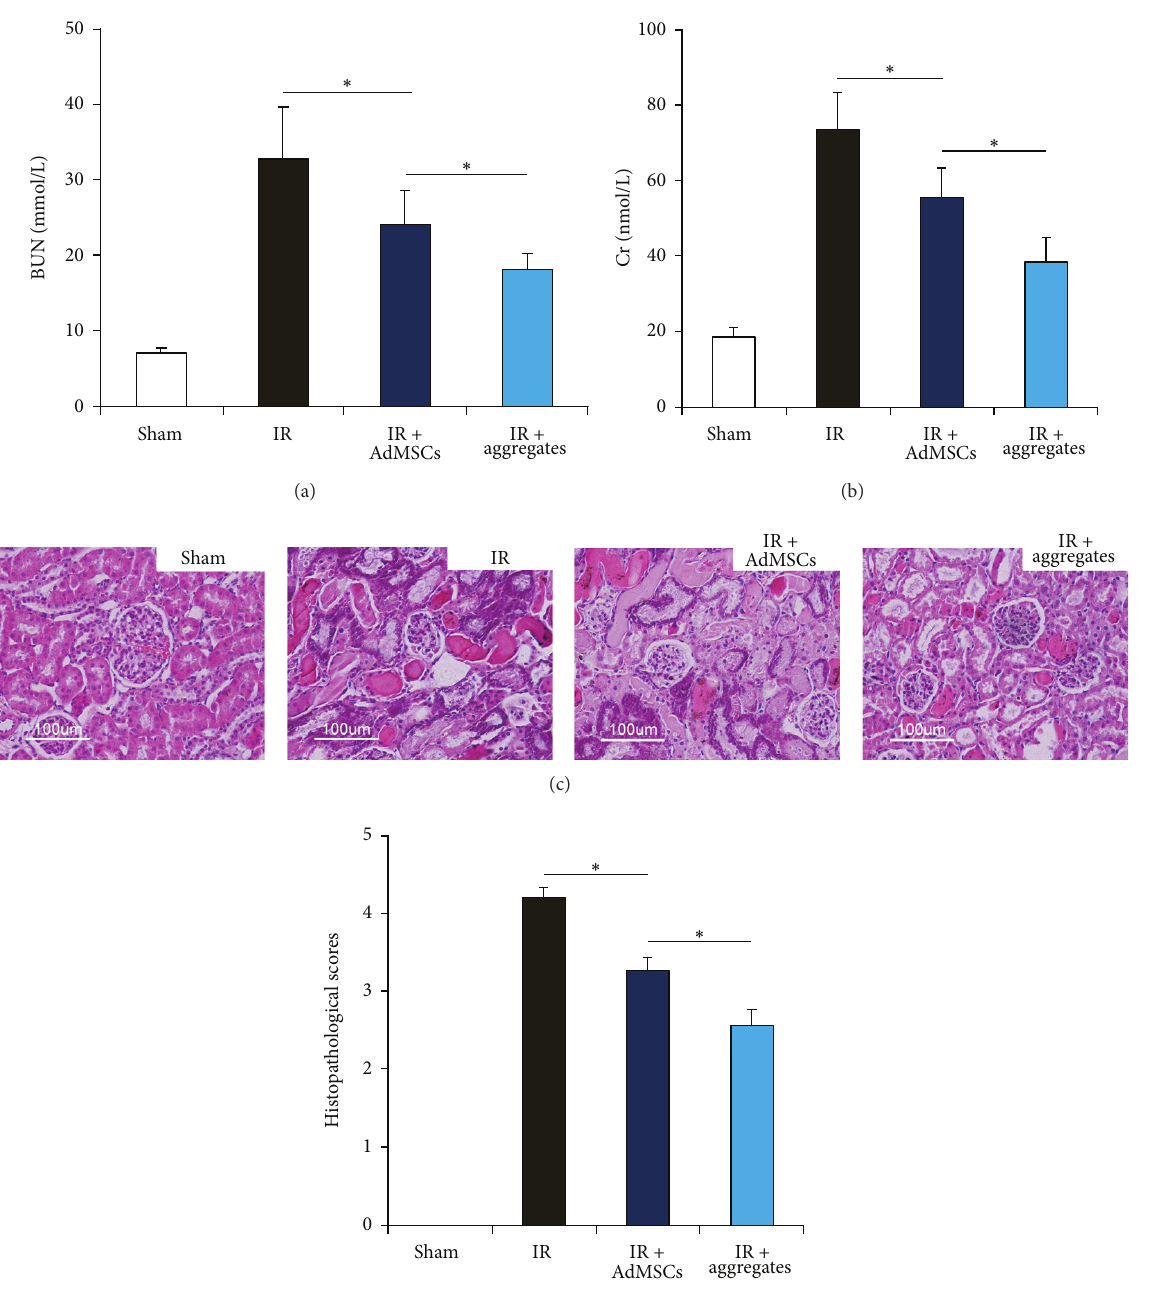
Figure 4: 2D AdMSCs or 3D aggregate preserves renal function and histology after IR. ((a)-(b)) Circulating levels of urea nitrogen (BUN) and creatinine (Cr) in different experimental groups ( 𝑛 = 6 in each group). (c) Representative images of HE staining of kidney sections in each experimental group, showing significantly higher degree of tubular damage including tubular necrosis, cast formation, dilatation of tubules, and loss of brush border in IR group. (d) Results of total histopathological scores reflecting tubular damage in each group. ∗ 𝑃 < 0.05